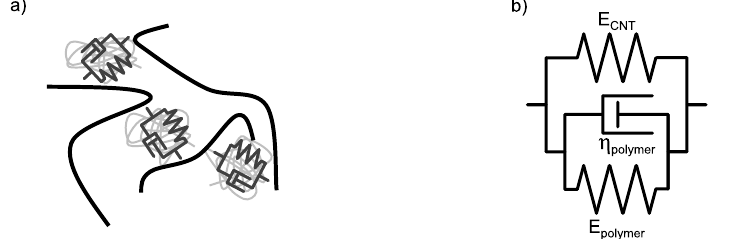
Figure 12. Master curve of the rheological properties of 0.5wt% NC7000 dispersed in Epikote 828LVEL.